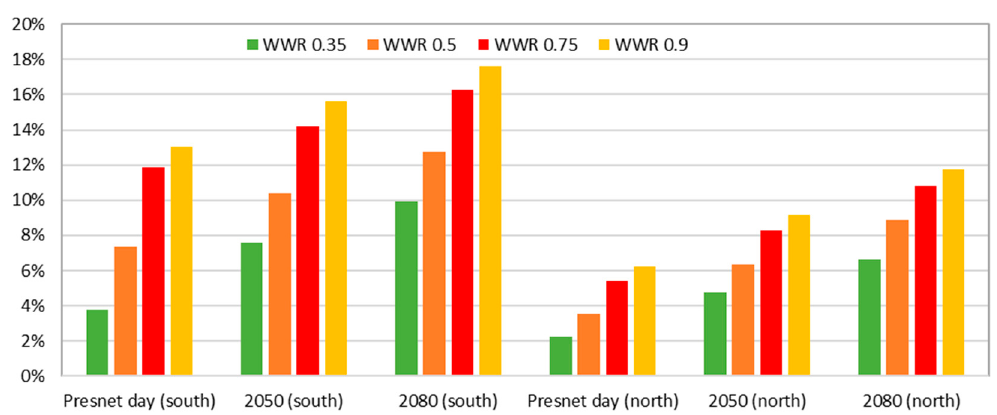
Figure 7. Annual percentage beyond the acceptable temperature 25 °C (tight building model) based on the Passive House Planning Package (PHPP).